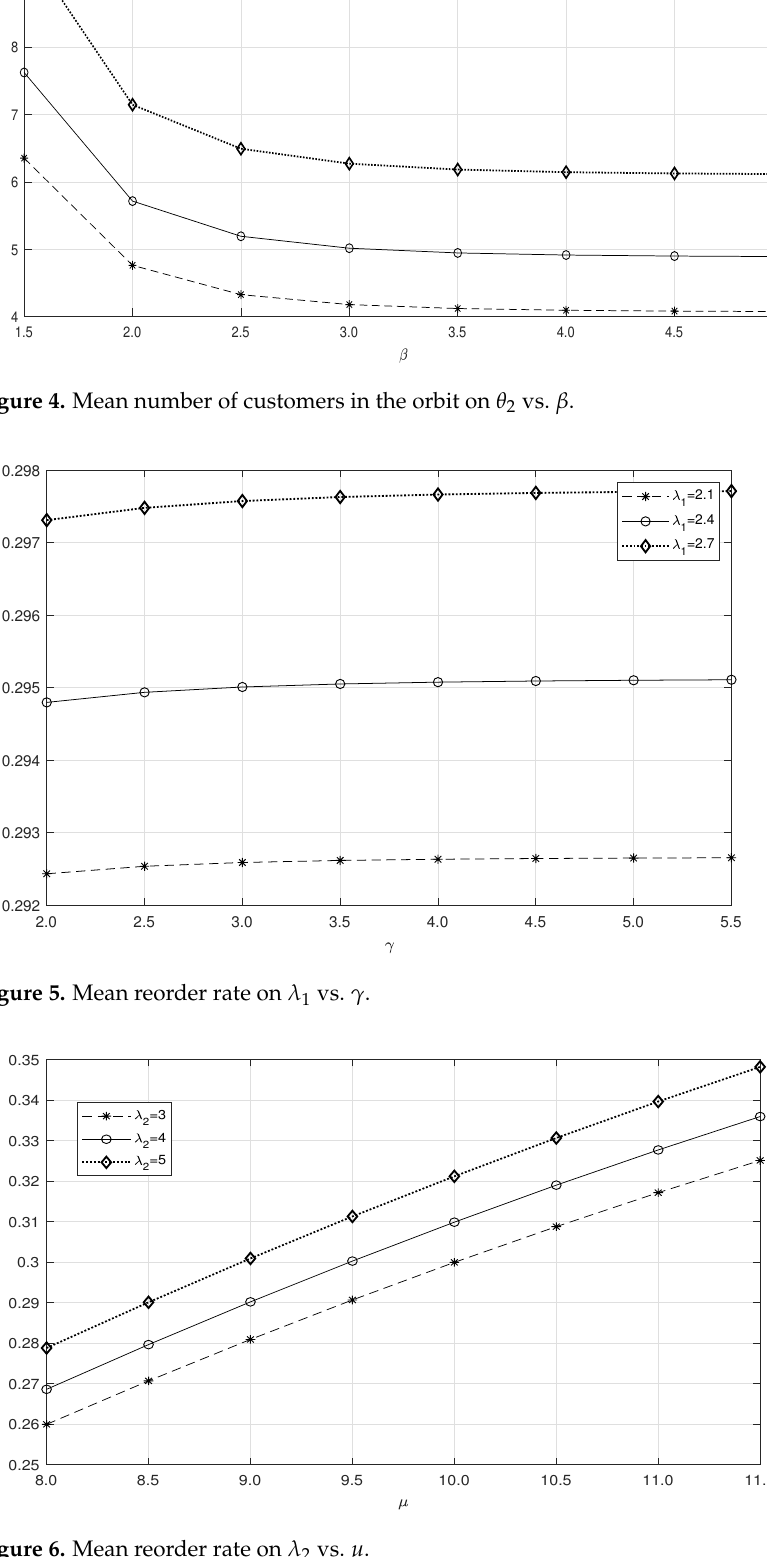
Figure 6. Mean reorder rate on λ 2 vs. µ